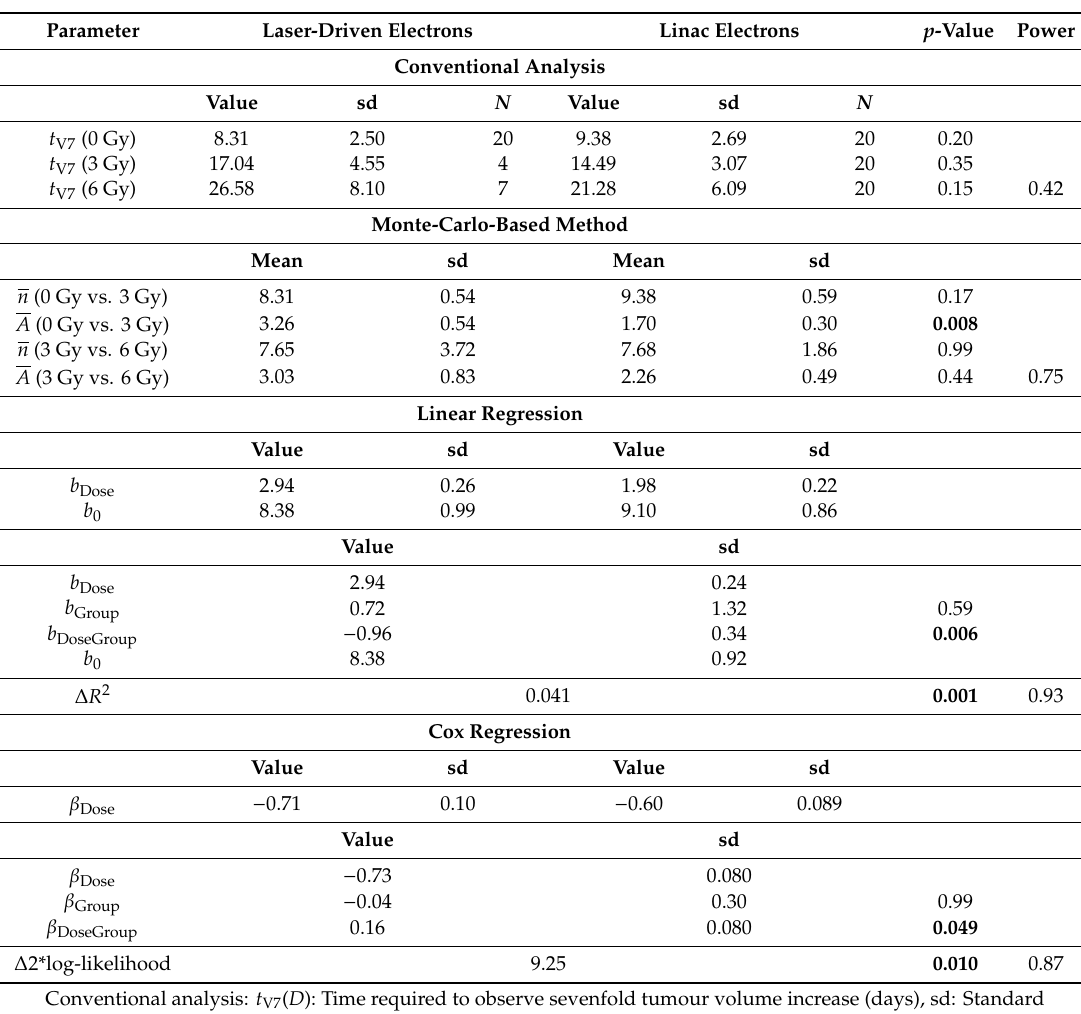
Table 2. Summary of relevant parameters returned by the di ff erent statistical methods applied to the simulated tumour-growth data. Units (days, Gy) are ignored for clarity. Significant p -values are marked in bold. The power was estimated based on 10000 repetitions of the